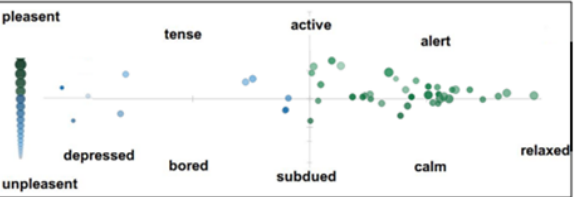
Figure 4. Sentiment analysis related to the hashtag #nuevoaeropuerto, September 16, 2014.